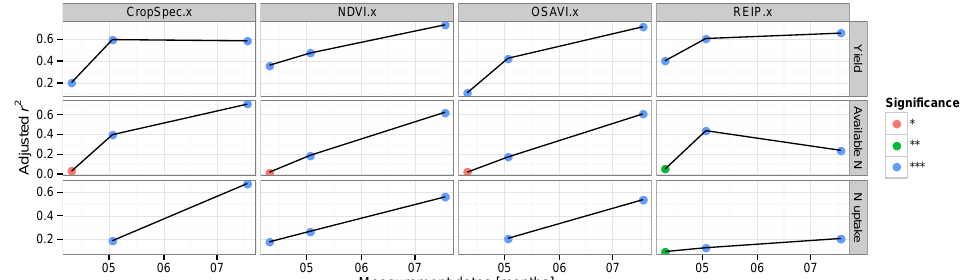
Figure 5. Adjusted r 2 values for indices of HandySpec Field (*.x) sensor over the 2012 measurement period. The colour expresses the different significance levels: *** p -value < 0.001; ** p -value < 0.01; * p -value < 0.05.